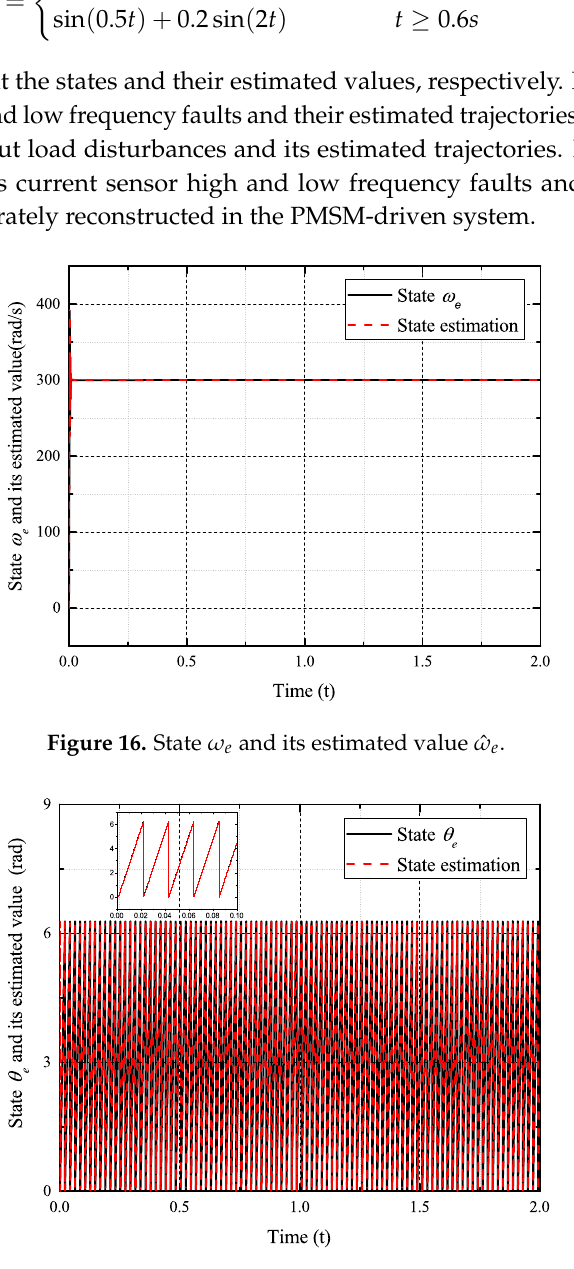
Figure 17. State θ e and its estimated value ˆ θ e